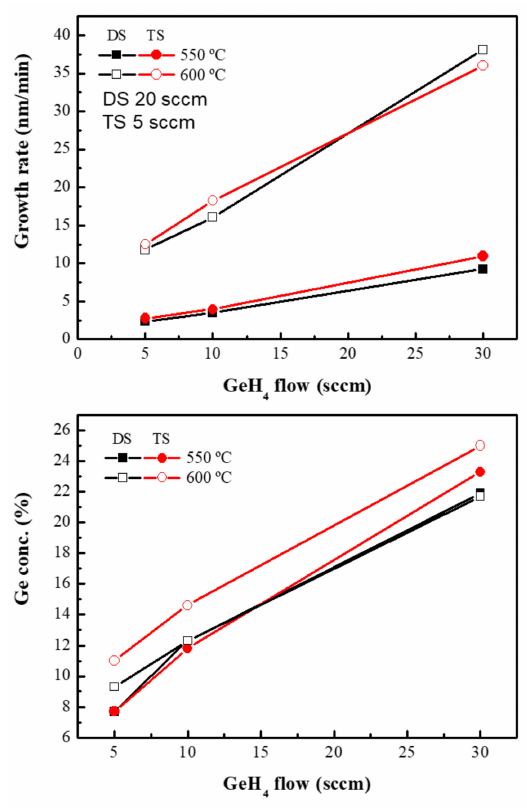
Figure 6. Growth rate and Ge concentration versus the Ge flow rate of the SiGe epilayers grown using disilane and trisilane at 550 and 600 ◦ C. The flow rates of disilane and trisilane were 20 and 5 sccm,